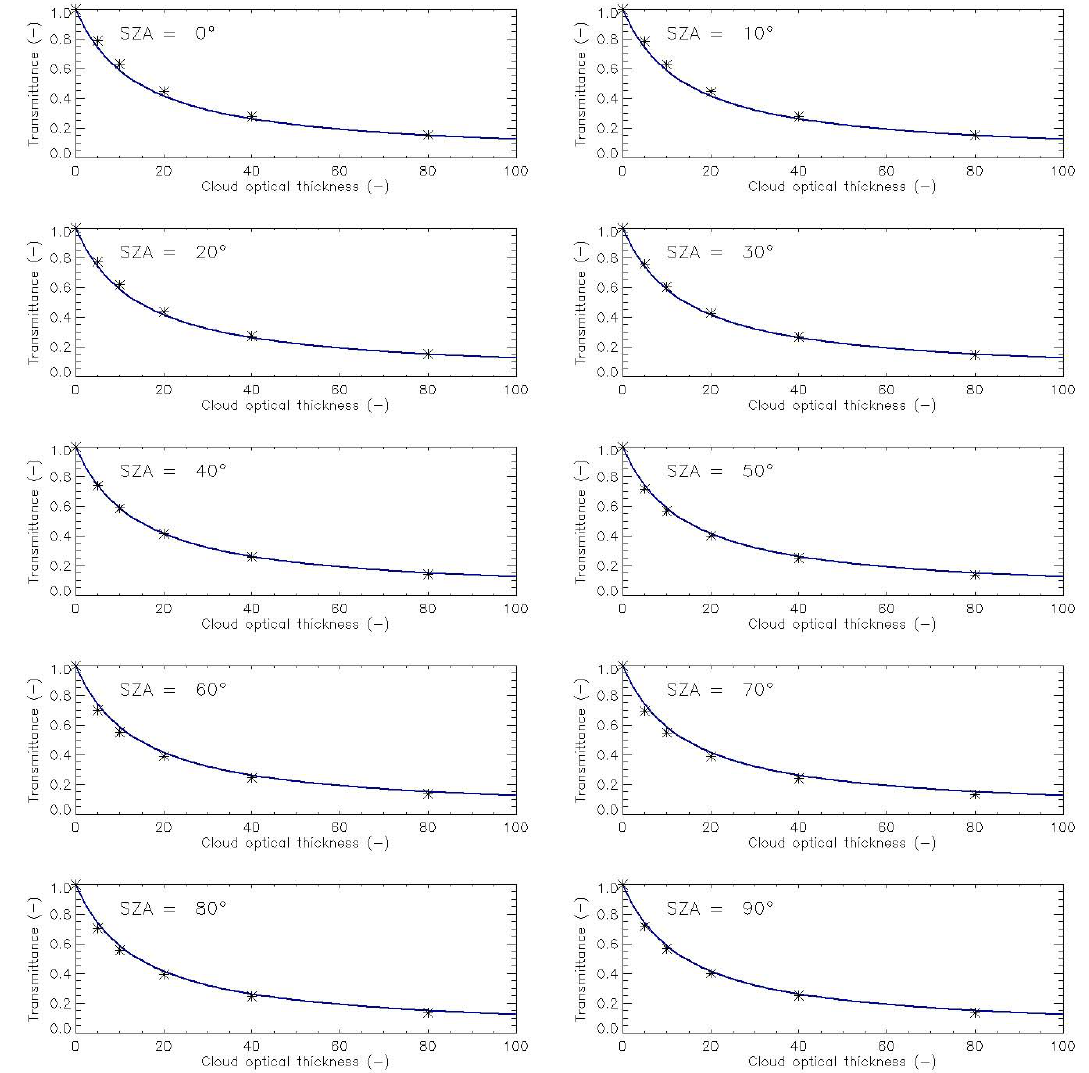
Fig. 2. The parameterised transmittance given by Eq. (6) (continuous curve) and the transmittance computed from TUV model simulations